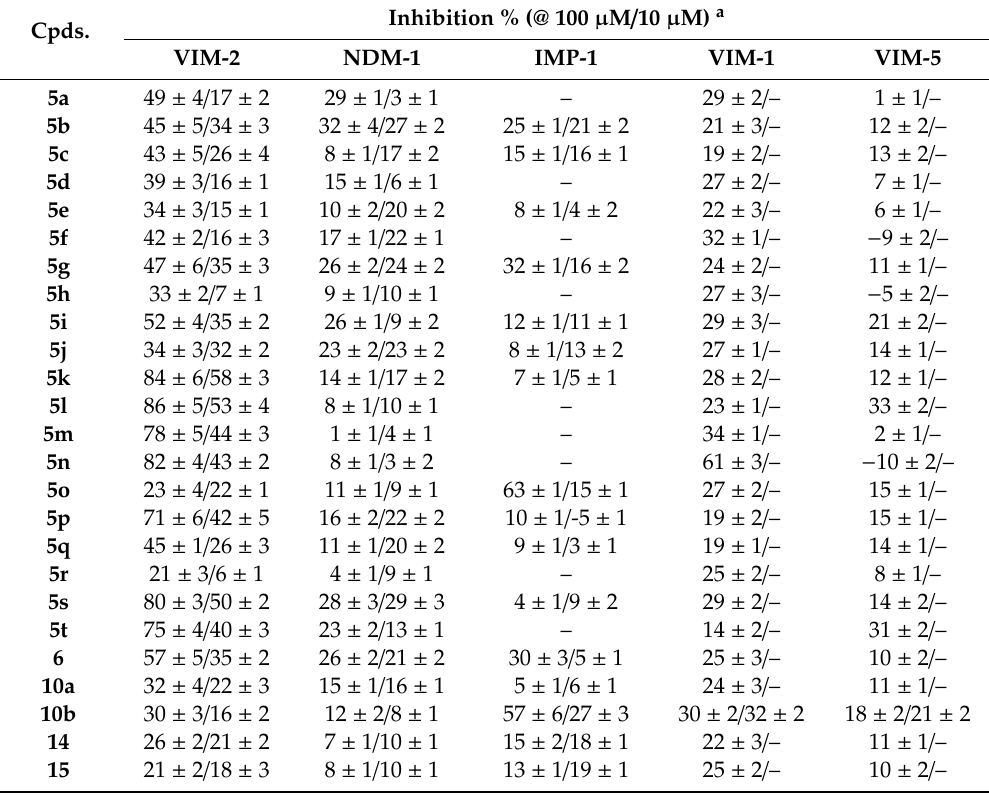
Table 1. Inhibitory activities of target compounds against representative MBL enzymes. Cpds.